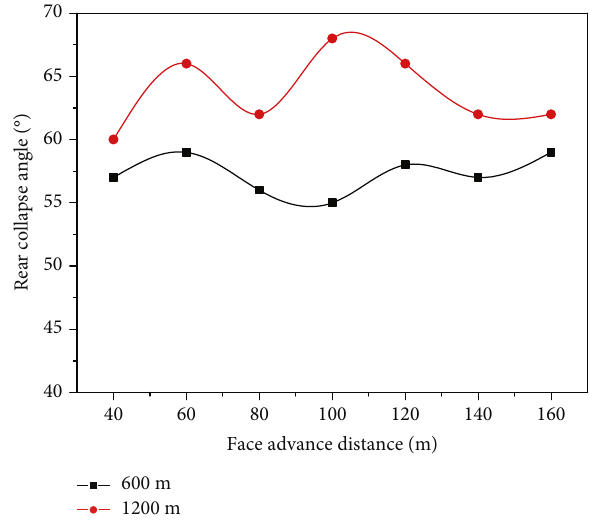
Figure 13: The change rule of the rear collapse angle with di ff erent advancing